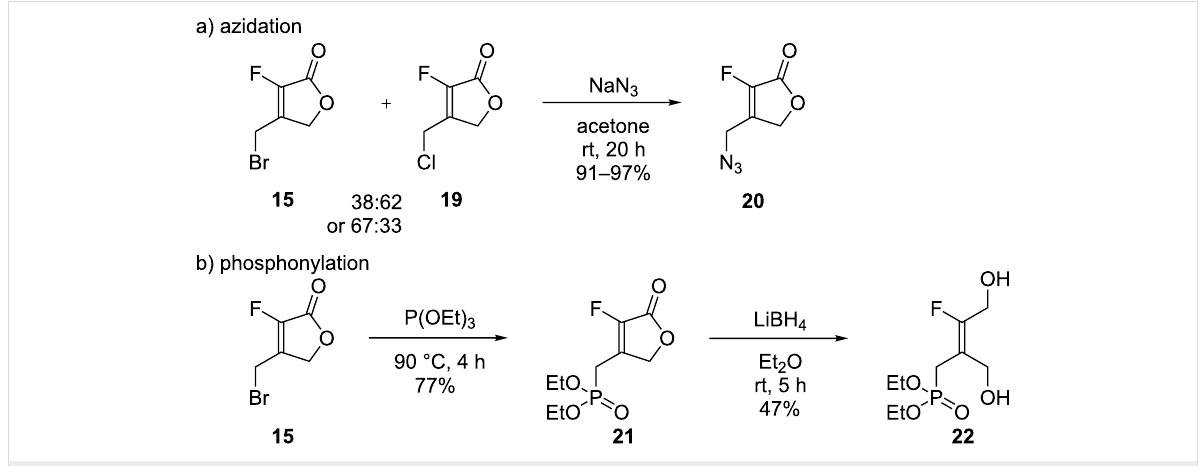
Scheme 7: Functionalization of bromomethyllactone 15 and its